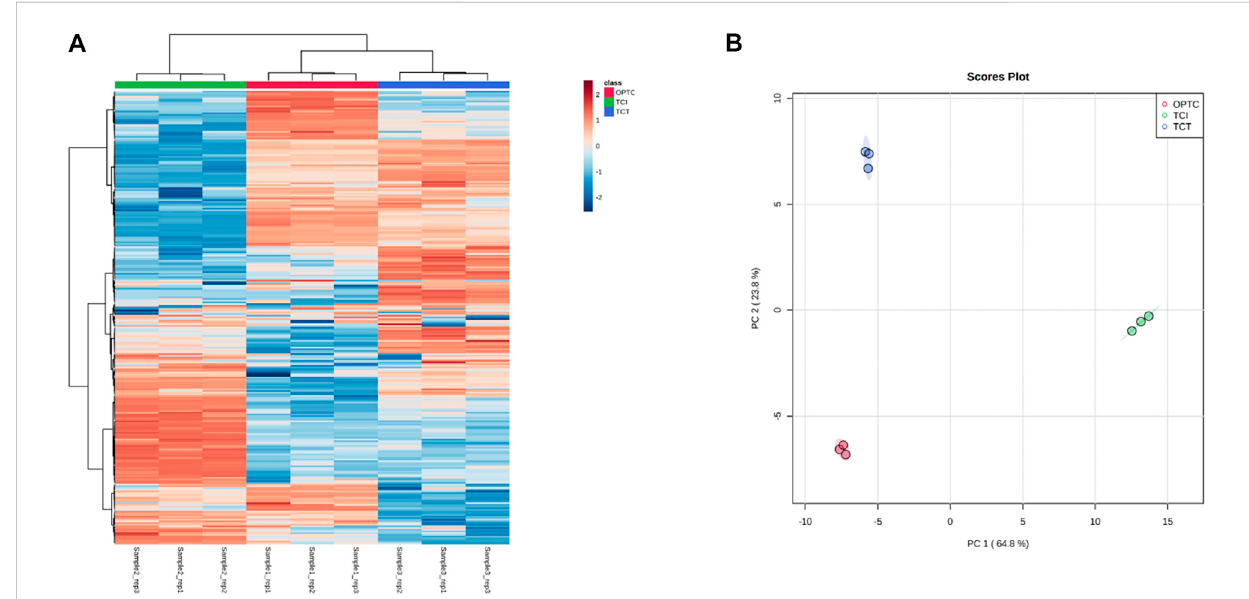
Supervised OPLS-DA built considering the untargeted phenolic pro fi le of T. comosus following different extraction methods, namely OpTC, TCI, and